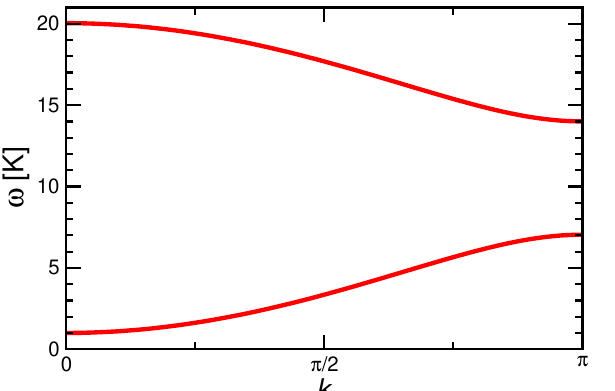
Figure A1. The one-magnon dispersion (A2) and (A3) for J = 2.8 K, D = 0.36 K, and d =